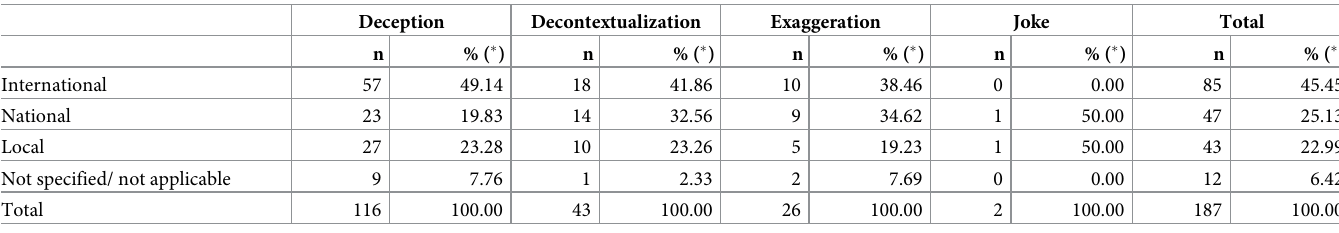
Table 10. Types of hoaxes according to geographical scope.